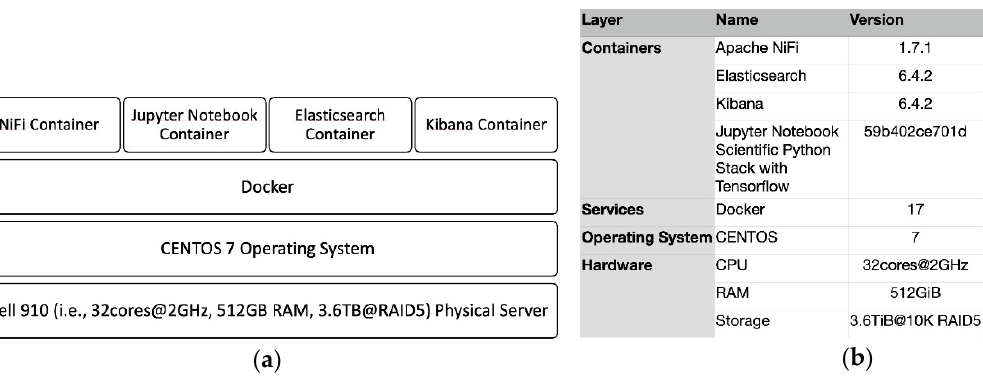
Figure 1. ( a ) Overview of the system architecture. ( b ) Specifications of the